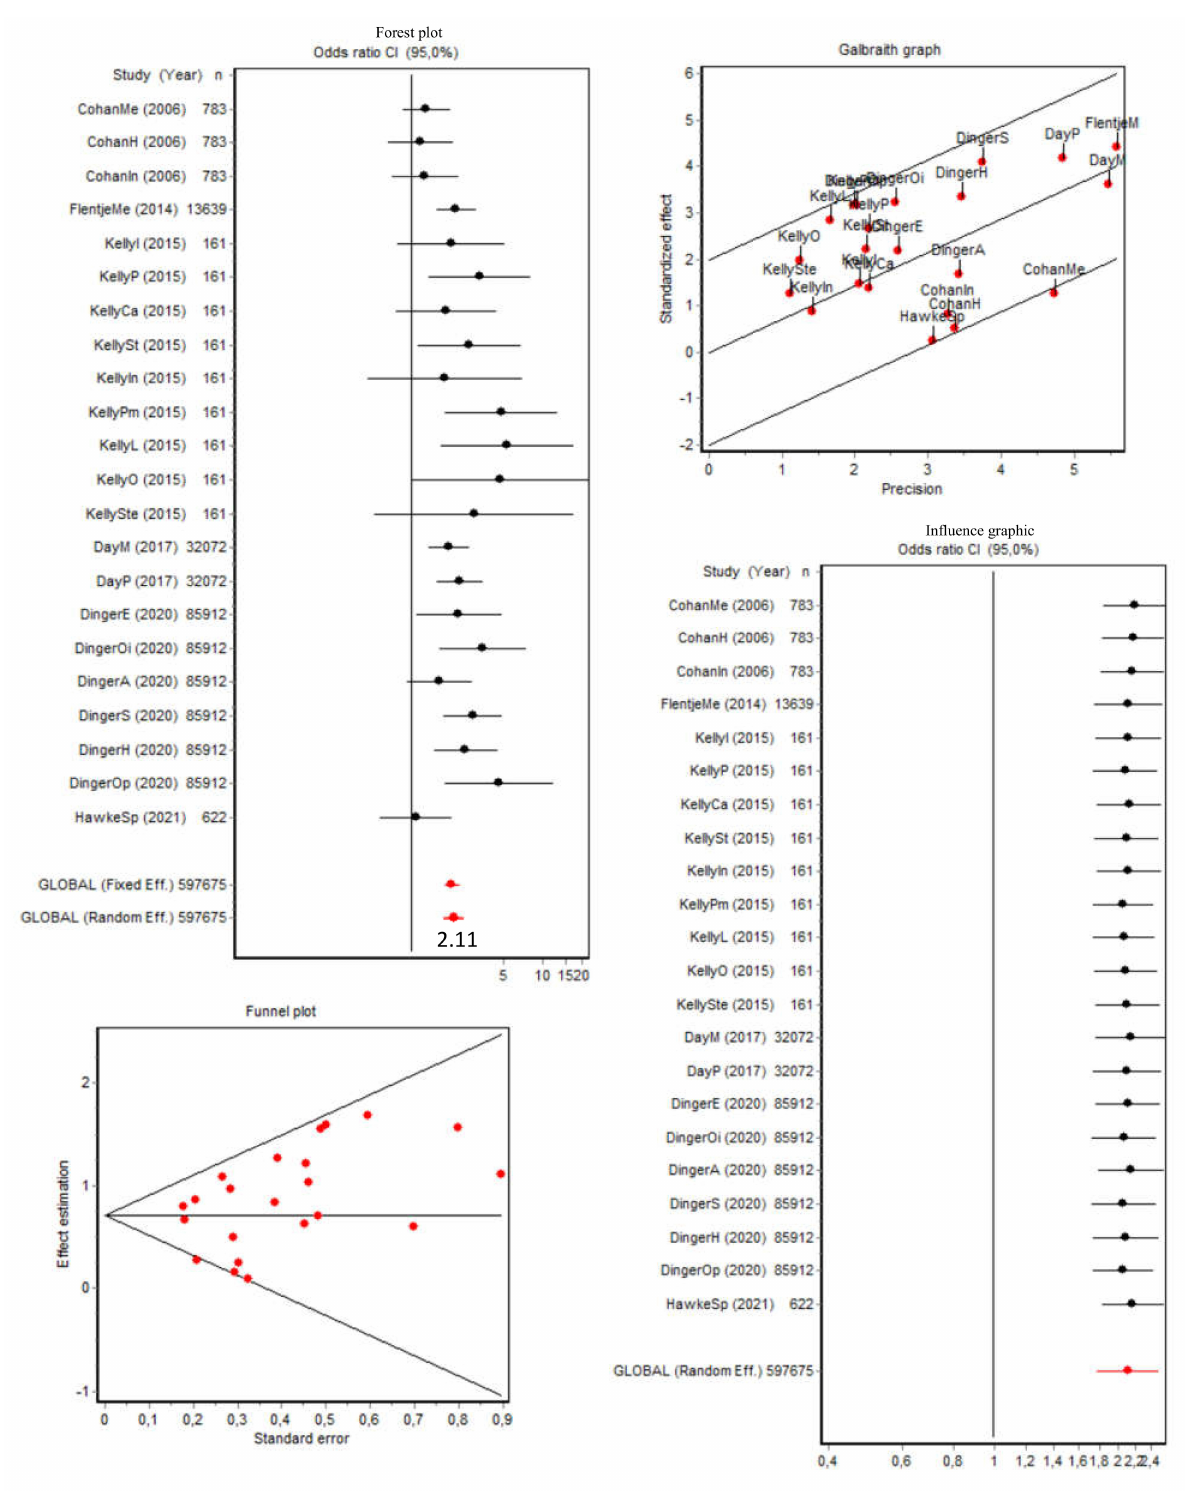
Figure 6. Forest plot, Galbraith graphic, influence graphic, and funnel plot for the current use of specific substances (excluding tobacco and alcohol) with subgroup analysis. Abbreviations: Me, methamphetamines; H, heroin; In: inhalants; P, polysubstance; Ca, cannabis; St, stimulants; Pm, prescription medications; L, LSD; O, opiates; Ste, steroids; M, marijuana; E, ecstasy; Oi: other illegal drugs; A, amphetamines; S, sedatives; Sp, current substance use